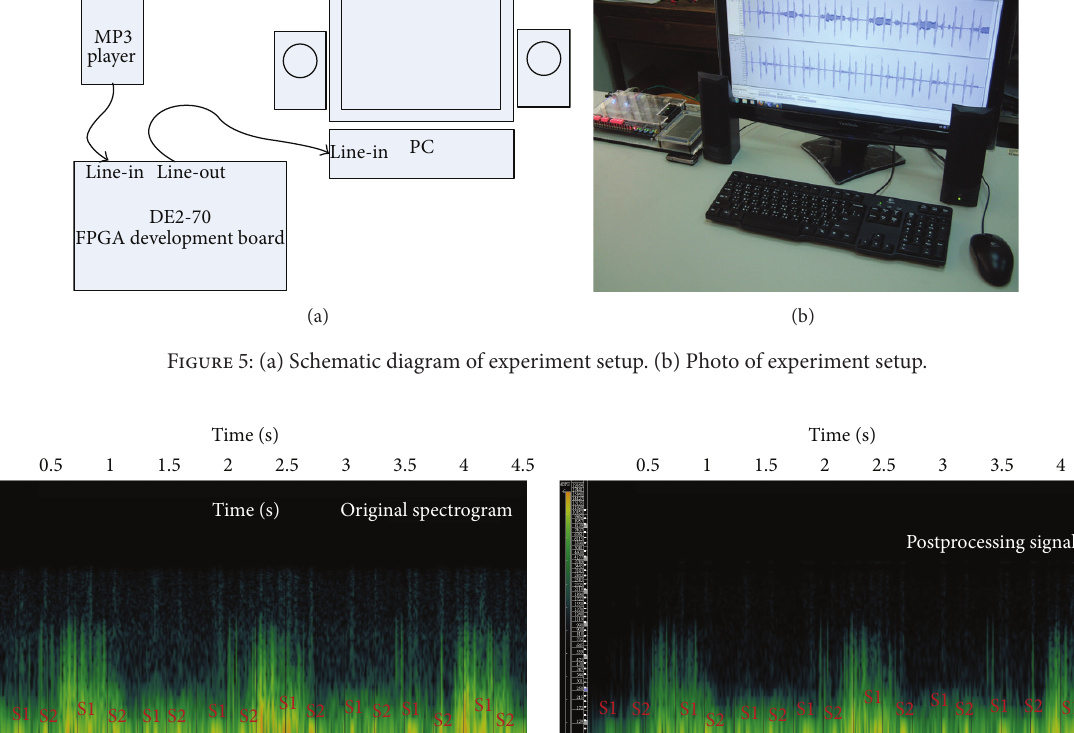
in the spectrogram. S1 and S2 represent the first and second heart sounds,